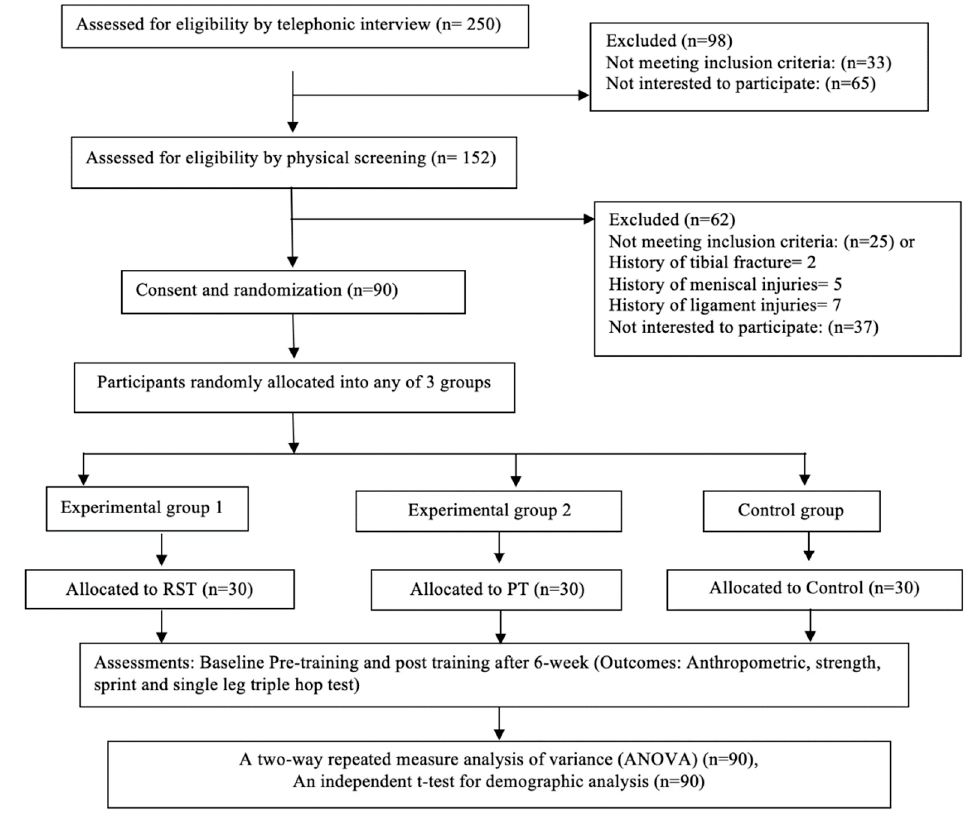
Figure 1. Consolidated Standards of Reporting Trials (CONSORT) diagram showing the flow of participants through each stage of a randomized trial. RST: resisted sprint Training, PT: plyometric Training.